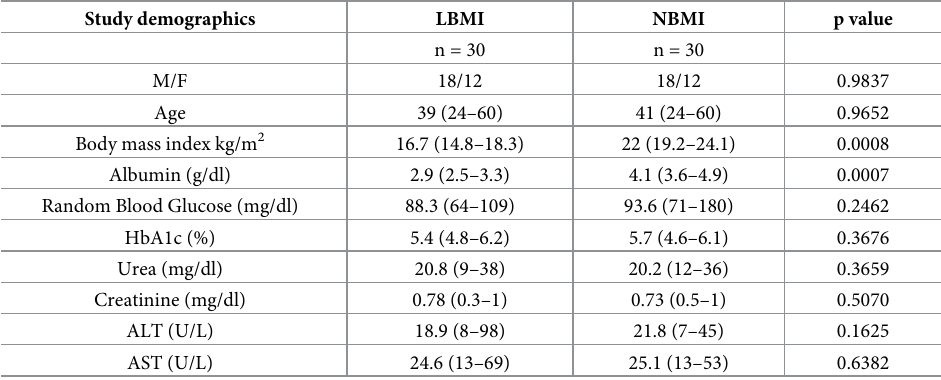
Table 1. Demographic profile of the study population.